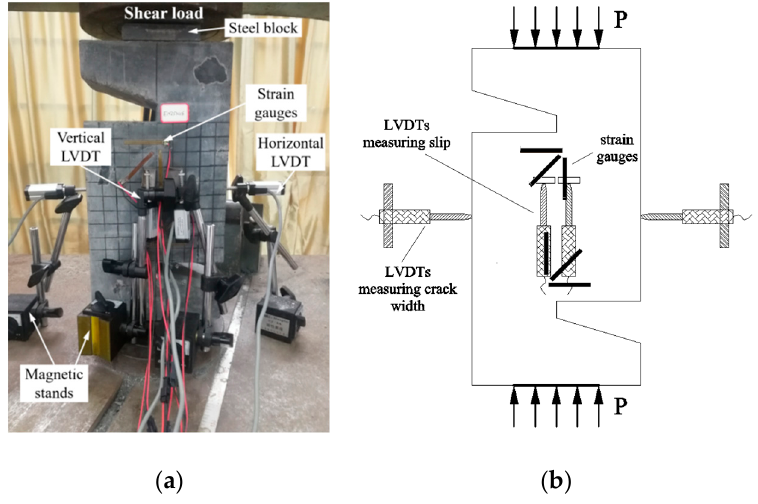
Figure 7. Test set-up. ( a ) Photo of test set-up and ( b ) arrangement of the transducers.